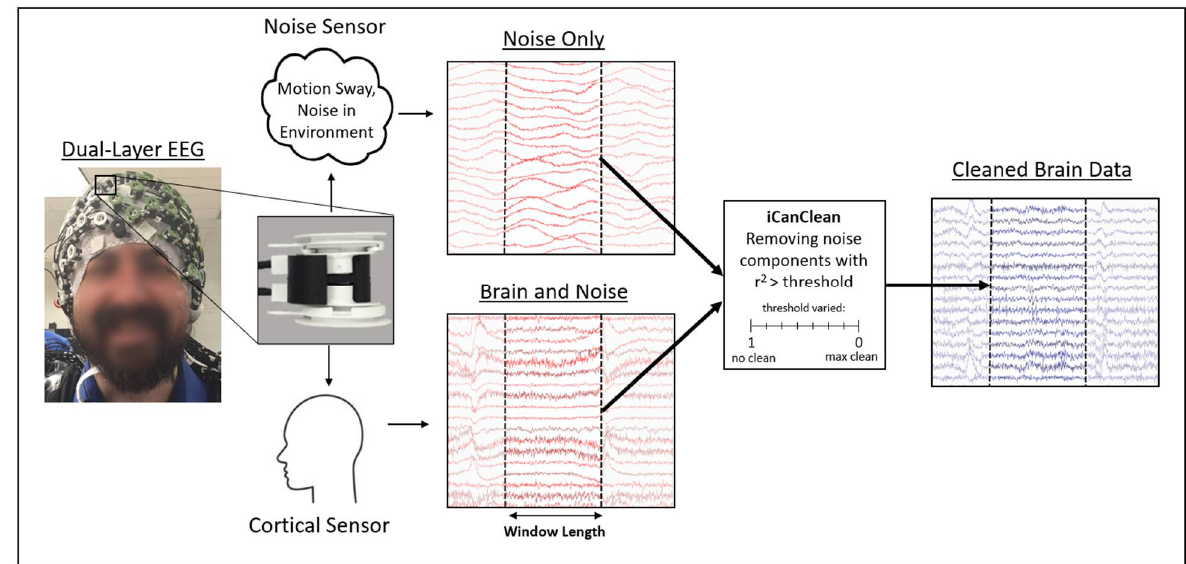
Figure 1. Illustration of the way iCanClean works. The participant is fitted with a dual-layer EEG cap consisting of inverted noise electrodes coupled to cortical electrodes. Example signals from dual-layer EEG are shown. The cortical electrodes record brain signals, but they also are commonly corrupted by noise and artifactual sources such as motion artifacts. The noise sensors are not in contact with the scalp and therefore only collect noise. iCanClean detects and removes subspaces of the EEG signals that are highly correlated with subspaces of the noise signals using canonical correlation analysis (CCA) [24]. The main tuning parameter for iCanClean is the r 2 threshold. CCA components with an r 2 correlation greater than a user-selected threshold are removed. The second tuning parameter for iCanClean is the length of the window over which CCA is calculated. Shorter windows could be useful for cleaning non-stationary data (e.g., large drifts), whereas longer windows provide better noise identification and removal, assuming the data are sufficiently stationary given the window length.